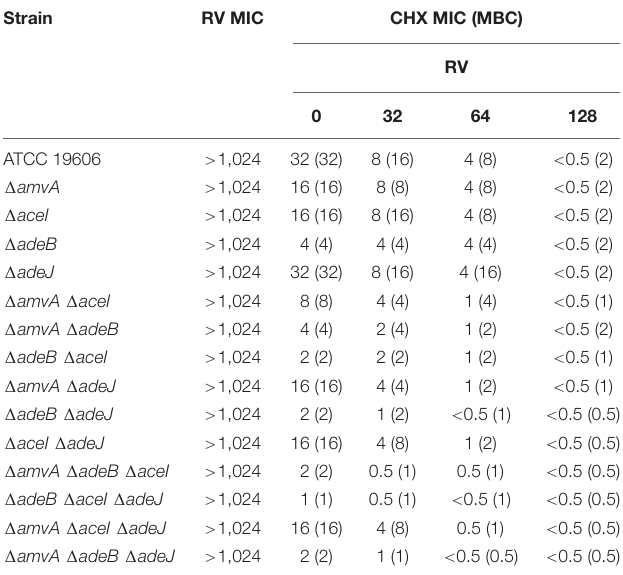
TABLE 6 | RV effect on CHX MIC (mg/L) and CHX MBC (mg/L) in A. baumannii ATCC 19606 parental strain and EP deletion mutants. Strain RV